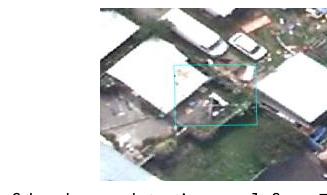
Figure 15. Left: a cut of the change detection result from Figure 7 that corresponds to the surroundings of validation point 2 in Figure 13; right: an aerial photo that covers the region of validation point 2.